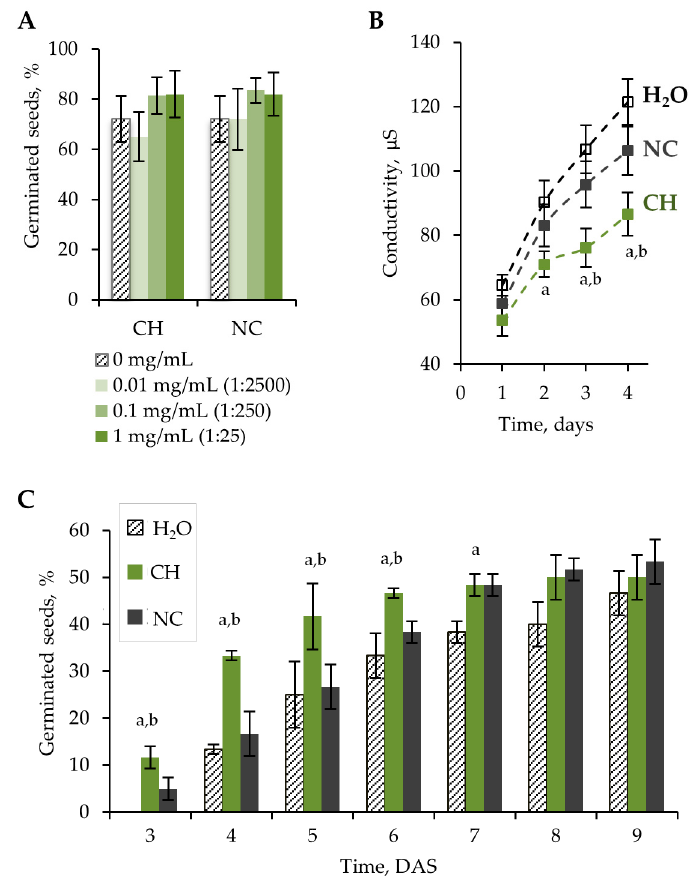
Figure 1. ( A ) Percentage of germinated seeds at the 10th day of incubation as a function of sample concentration in the germination test. ( B ) Conductivity of seed leachates at 1–4 days of incubation in distilled water. Seeds were treated with H 2 O, 0.1 mg/mL CH (dilution ratio 1:250), and NC (dilution ratio 1:250). ( C ) Percentage of germinated seeds at 3–9 DAS in peat substrate. Seeds were treated with H 2 O, 0.1 mg/mL CH (dilution ratio 1:250), and NC (dilution ratio 1:250). Error bars represent the standard deviation (SD) for three replications. Letters (a and b) indicate that values for CH-treated seeds are statistically significant compared to H 2 O- and NC-treated seeds, respectively, according to the Mann–Whitney U-test ( p < 0.05).